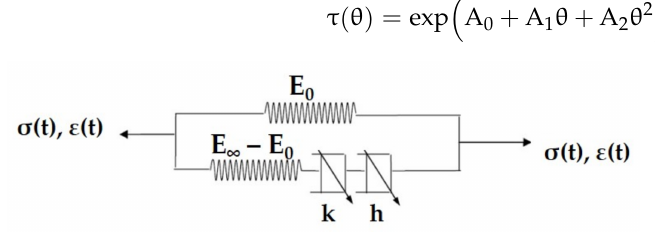
Figure 5. Huet–Sayegh model representation.